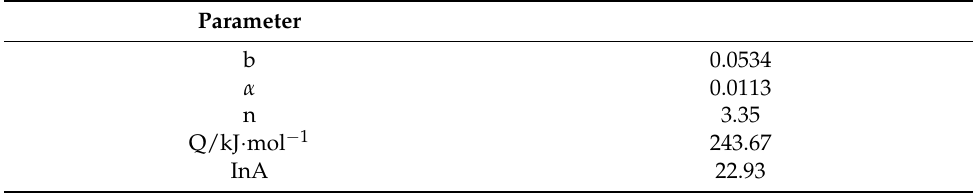
Table 2. Calculation results of each parameter of the constitutive equation.